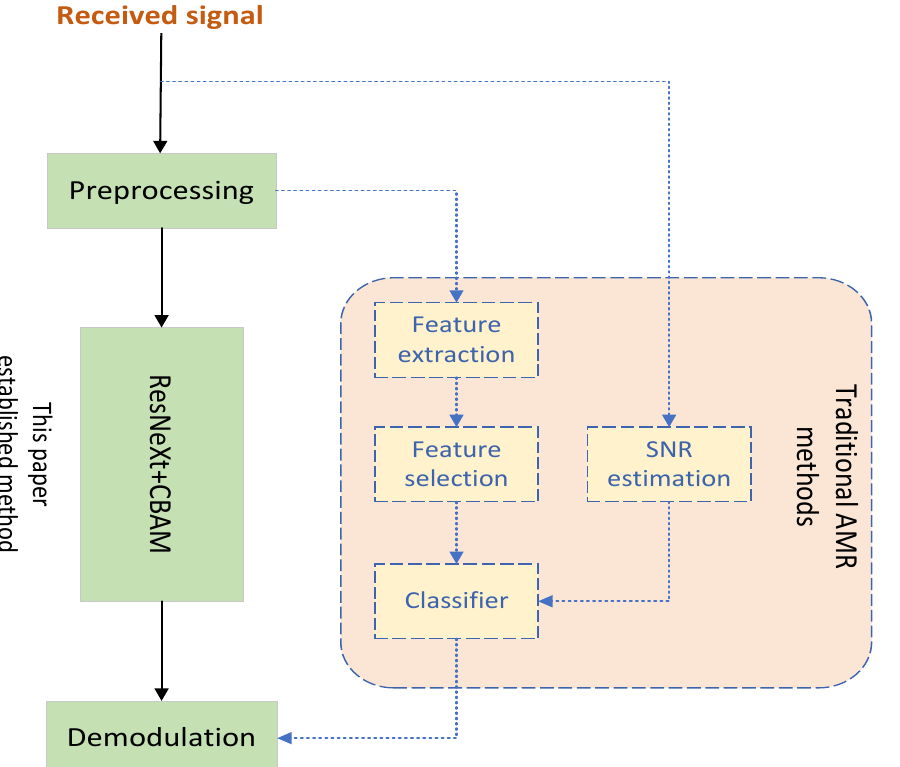
Figure 1. Automatic modulation recognition model